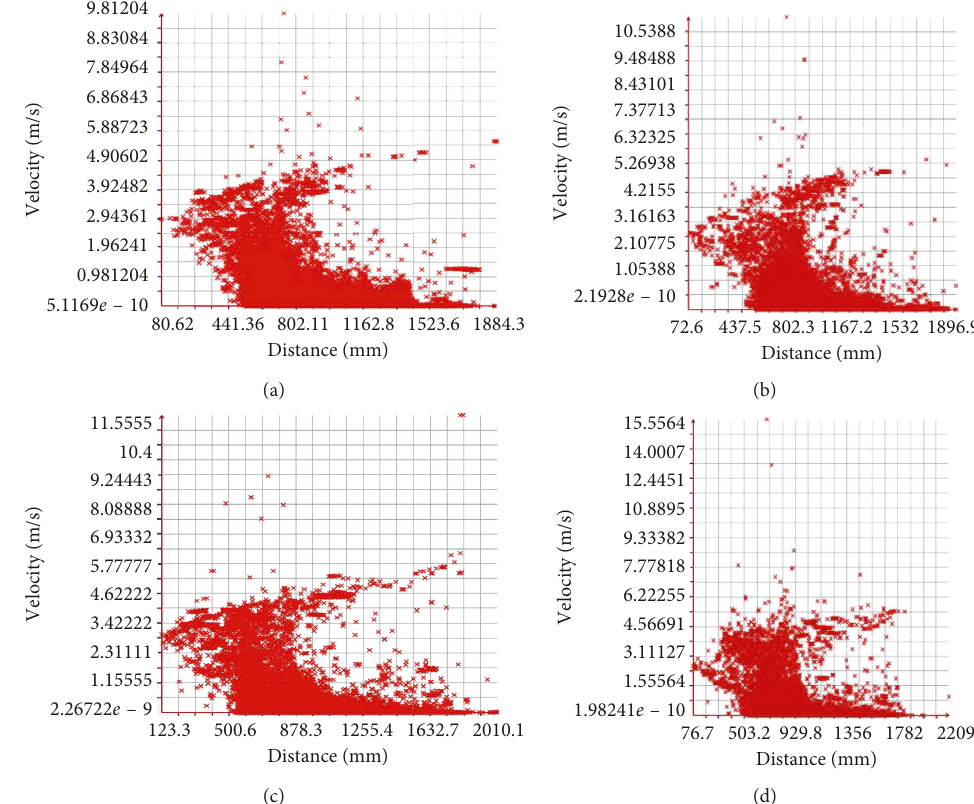
75r/min. (b) n (cid:31)